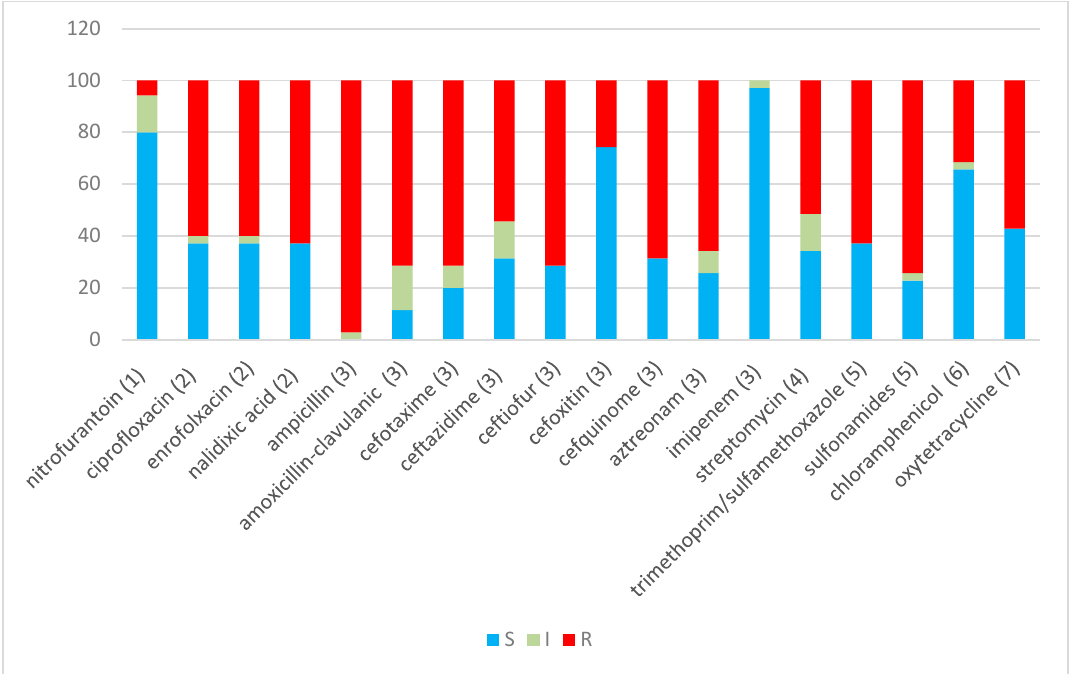
Figure 2. Percentage sensitivity to 18 antibiotics for 35 E. coli and non- E. coli isolates. Blue indicates sensitive, grey indicates intermediate sensitivity and red indicates resistance percentages, using CLSI (2013) definitions. The Y-axis represents the percentage of isolates. Antibiotic classes: (1) nitrofuran derivative, (2) quinolones, (3) β -lactams, (4) aminoglycoside, (5) sulphonamide/complex, (6) phenicol and (7) tetracycline.